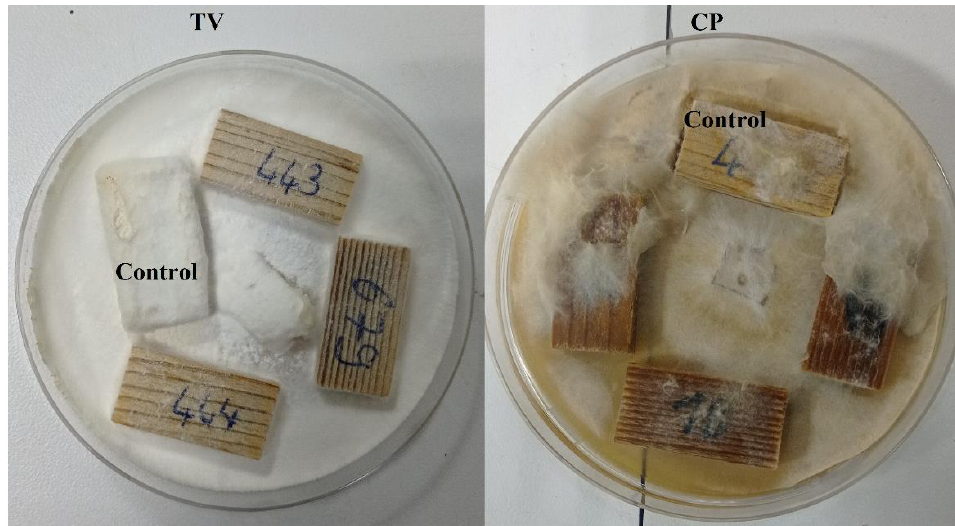
Figure 6. XRD patterns of spruce wood and PCMW.